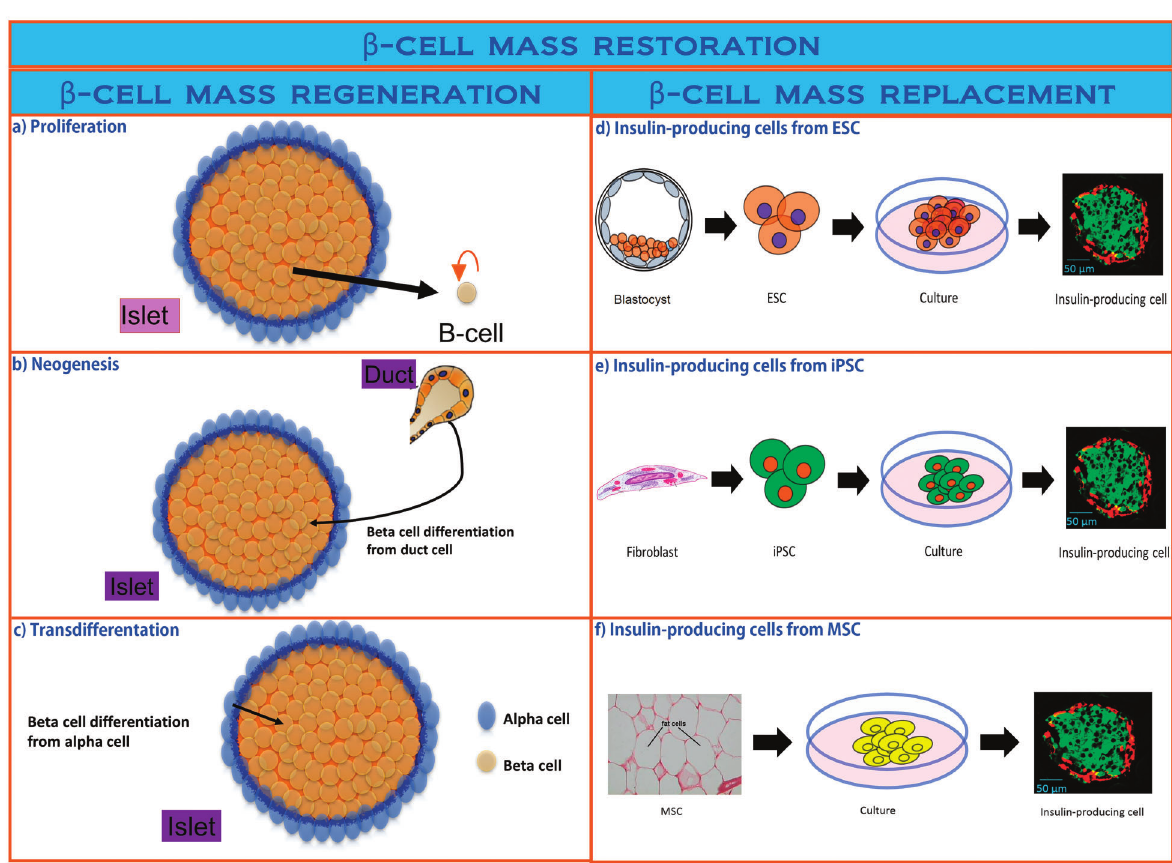
Figure 3. Different strategies for b -cell mass restoration. Novel strategies for b -cell mass restoration in diabetes therapy can be divided into the following groups: 1) b -cell regeneration, which includes proliferation ( a ), neogenesis ( b ), and transdifferentiation ( c ), and 2) b -cell replacement, which involves the transplantation of insulin-producing cells differentiated from embryonic stem cells (ESC) ( d ), induced pluripotent stem cells (iPSCs) ( e ), and mesenchymal stem cells (MSC) ( f ).